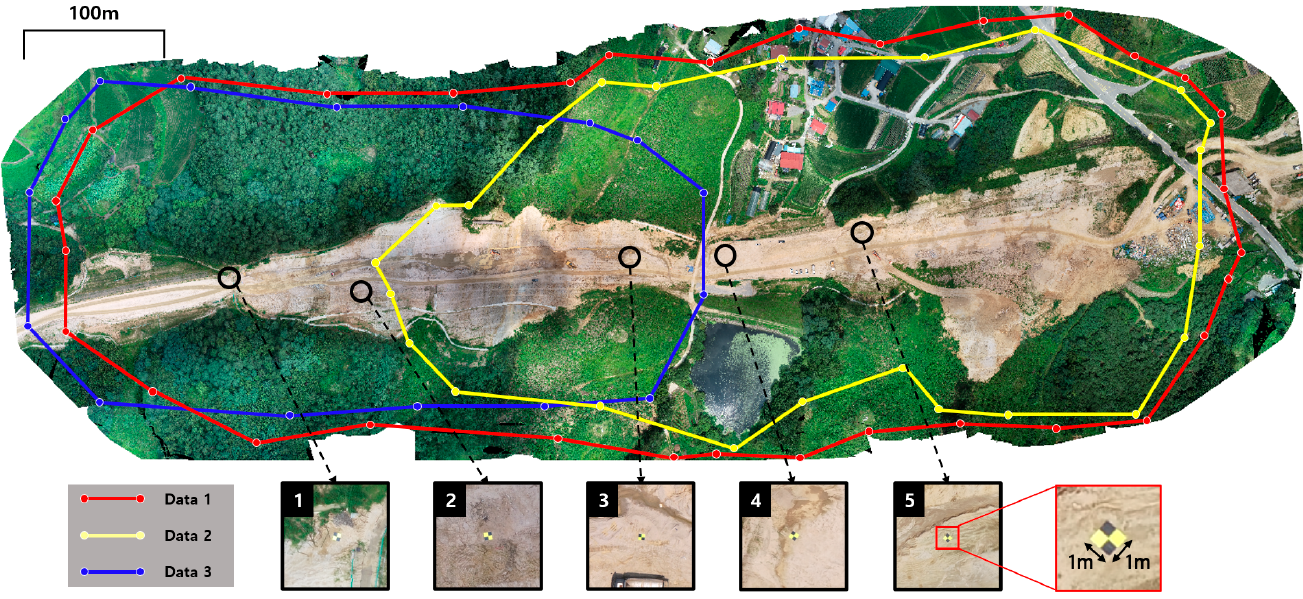
Figure 9. The whole area of the case study. Three flights were conducted: (1) red polyline indicates first flight area, called Data 1; (2) yellow polyline indicates second flight area, called Data 2; (3) blue polyline indicates third flight area, called Data 3.